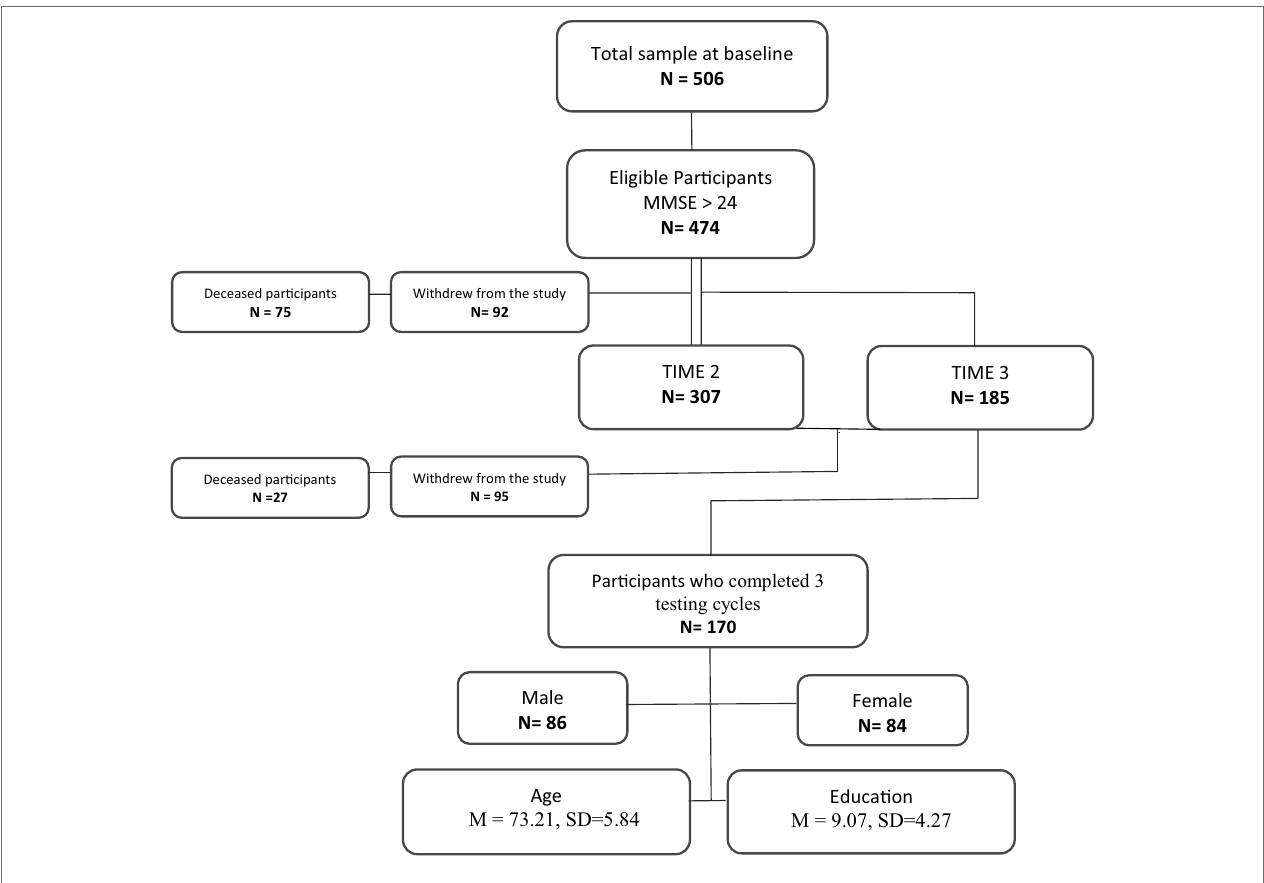
FIGURE 1 | STROBE flow